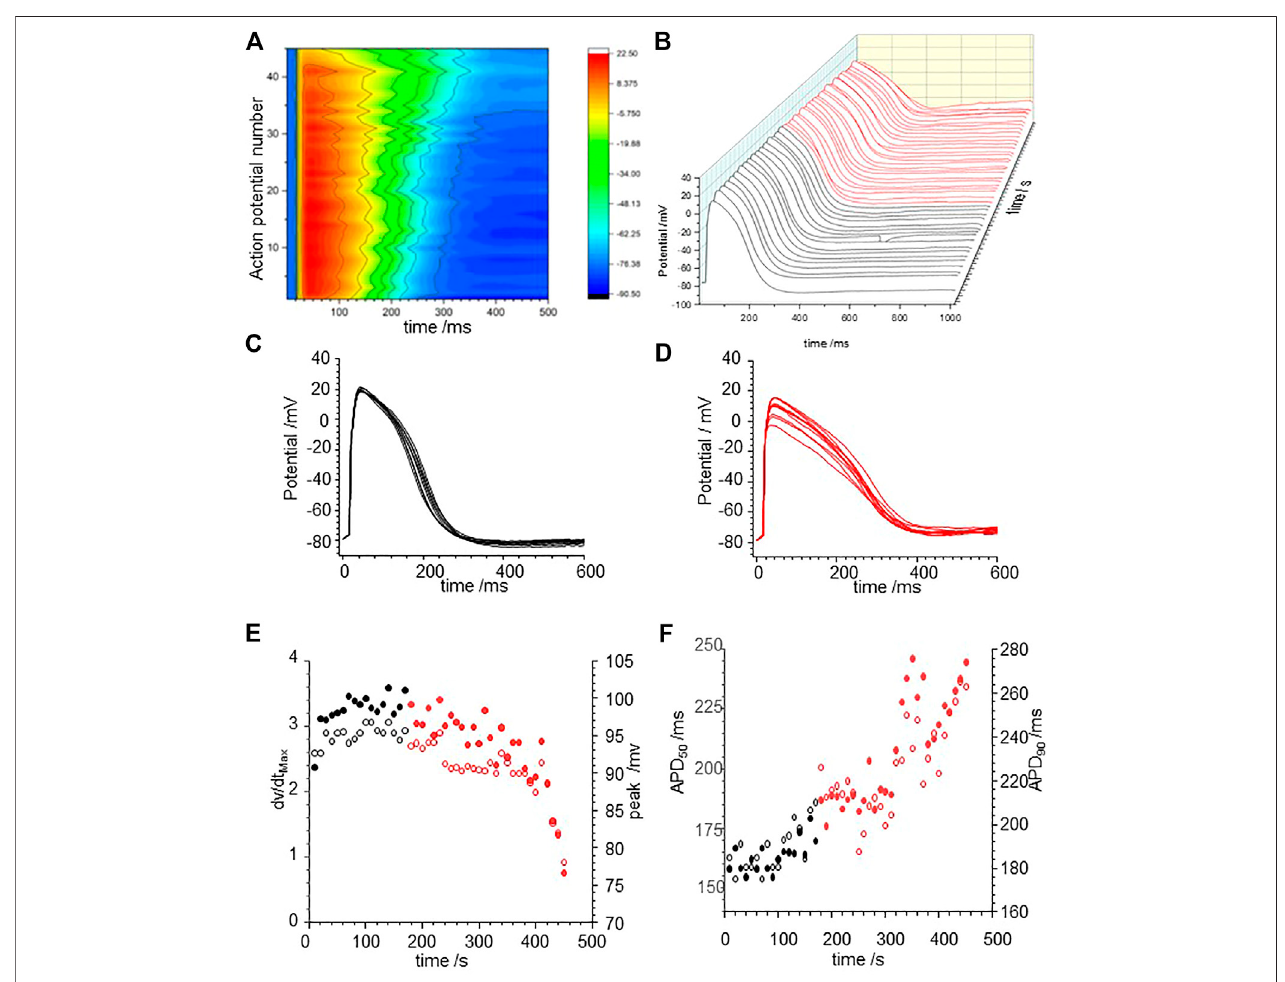
FIGURE 6 | CO prolongs action potentials of human iPSC derived cardiomyocytes (A) Color map of membrane potential during 45 cycles of pacing, with BCL of 10 s (B) staggered plot of V(t) during these action potentials. Black before effectof CO, red during development ofeffectof CO. (C) Intrinsic fl uctuations in APD 90 before effect of CO. (D) Progressive lengthening of evoked actions potentials during CORM-2 prefusion. (E) CO effect on the maximum rate of depolarization and duration of AP. Time series plot of peak ( fi lled symbols) and dV/dt max (open symbols) measurements. CORM-2 was perfused into the bath supply line at time 180 s. APD 50 (open symbols and APD 90 ( fi lled symbols) before (black symbols) and during (red symbols) the response to perfusion by CORM-2.